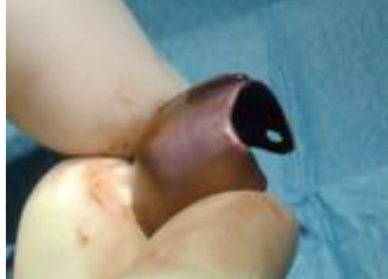
Figure 4. Crestal view of the bone after tooth extraction of 1.6. A small trabecula of alveolar bone was saved.